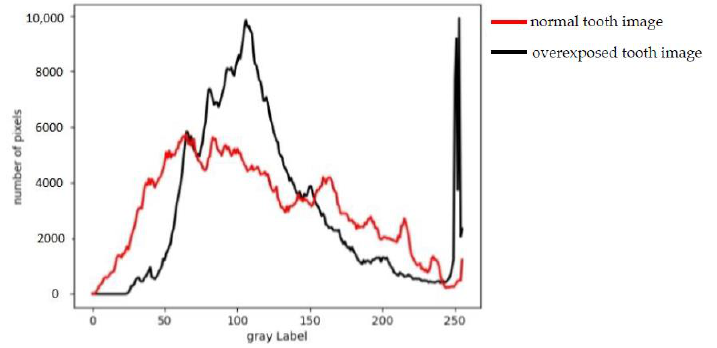
Figure 9. Comparison of gray histogram between a normal tooth image and an overexposed tooth image .